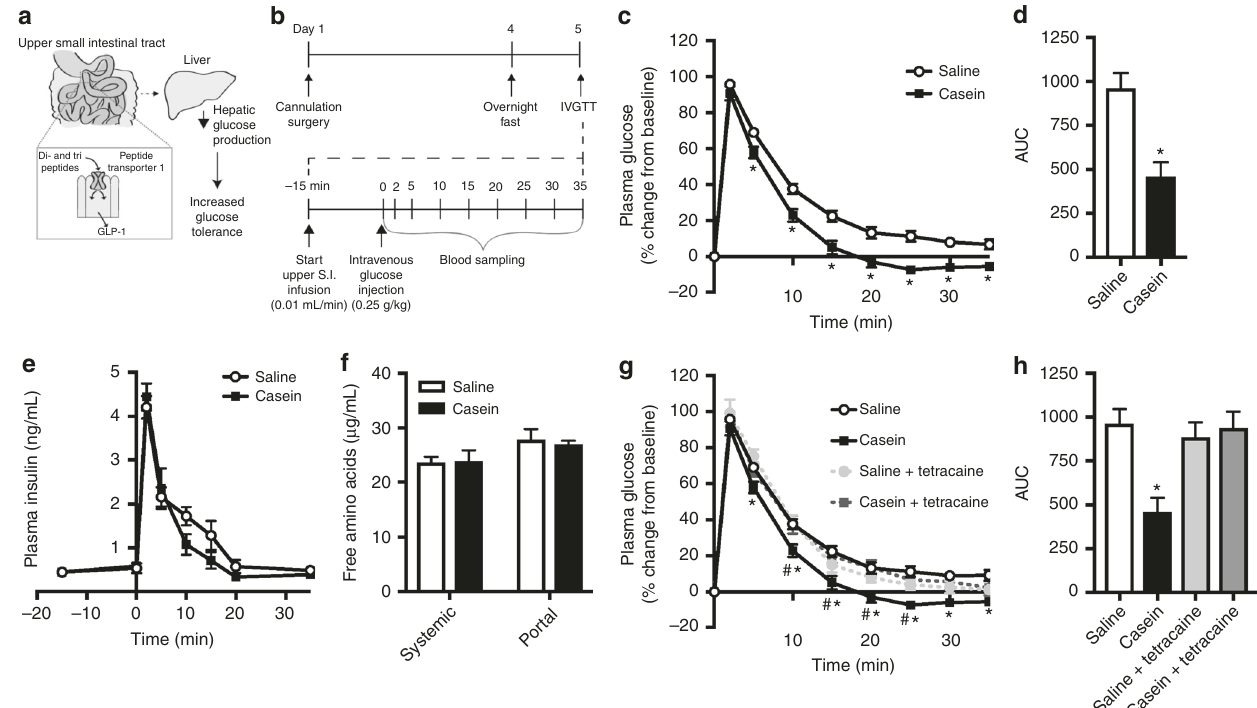
Fig. 1 Upper small intestinal infusion of casein hydrolysate increases glucose tolerance via preabsorptive mechanisms in healthy rodents. Schematic of hypothesis ( a ). Glucose tolerance was assessed in conscious, unrestrained healthy rats using an intravenous glucose tolerance test (IVGTT) as outlined in ( b ). Percentage of change in plasma glucose levels ( c ), integrated area under the curve (AUC, d ), and plasma insulin levels ( e ) over time during the IVGTT in rats that received an upper small intestinal (S.I.) infusion of saline ( n = 18) or 8% casein hydrolysate (pH 5.0, n = 24). Systemic and portal free amino acid levels were assessed in plasma obtained from rats following 50 min of upper S.I. saline ( n = 6) or casein ( n = 9) infusion ( f ). Percentage of change in plasma glucose levels ( g ) and integrated AUC ( h ) for rats that received an upper S.I. infusion of saline, casein, saline + tetracaine ( n = 5) or casein + tetracaine ( n = 8) during the IVGTT. Values are presented as mean ± s.e.m., where asterisk (*) represents p < 0.05 compared to saline control and hash (#) represents p<0.05 compared to casein + tetracaine. Statistical signi fi cance was determined using an unpaired, two-tailed t -test (two groups)